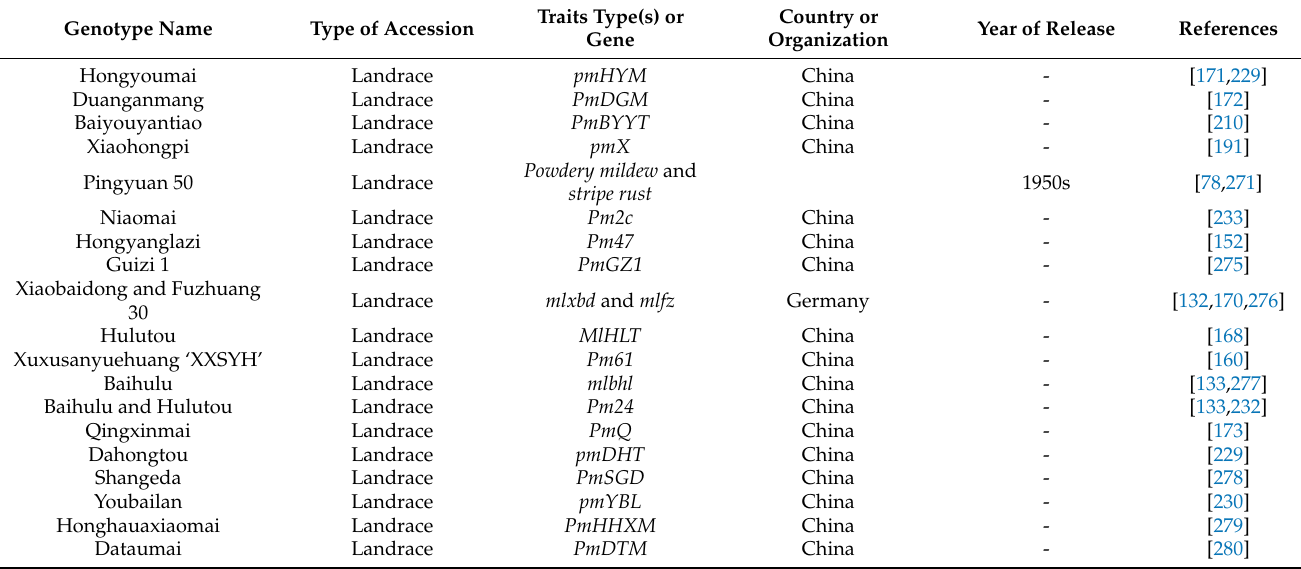
Table 3. Some modern wheat genotypes reporting PM resistance, agronomic, or other beneficial